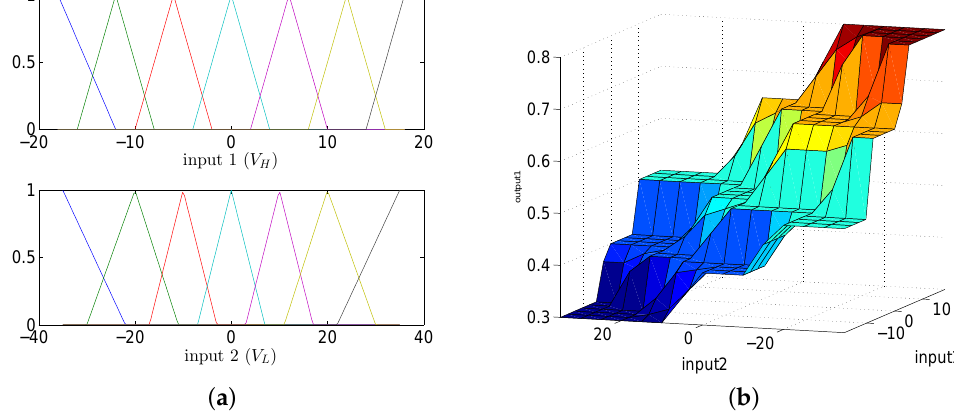
Figure 5. The fuzzy logic controller (Input 1 is V H ; Input 2 is V L ). ( a ) The input membership functions. ( b ) The fuzzy logic